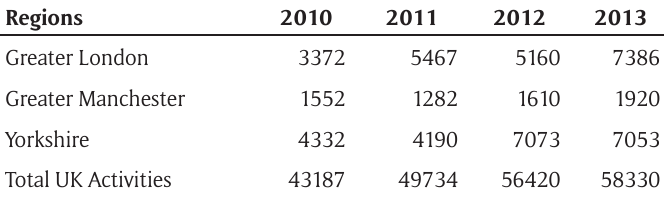
Table 2: Annual volunteering activities for each geographic area. Regions